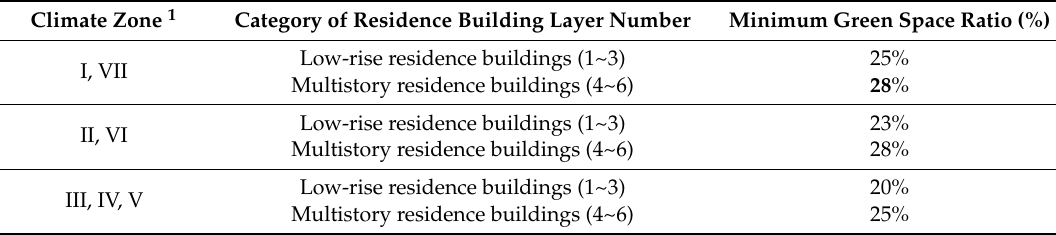
Table A2. Control index of Green Space Ratio of neighbourhoods in di ff erent building climate